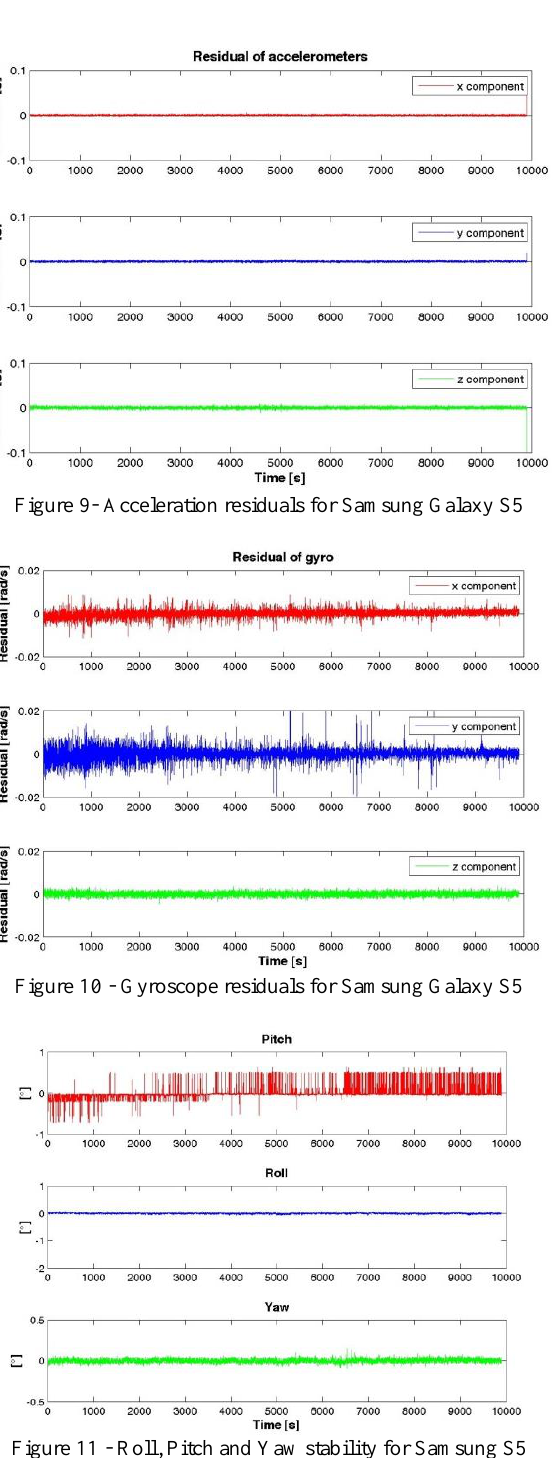
Figure 11 - Roll, Pitch and Yaw stability for Samsung S5